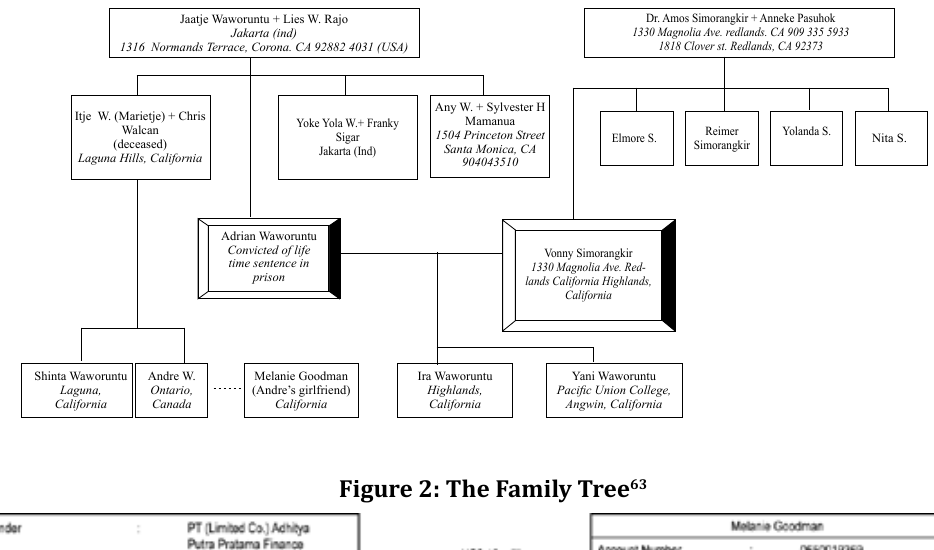
Figure 2: The Family Tree 63